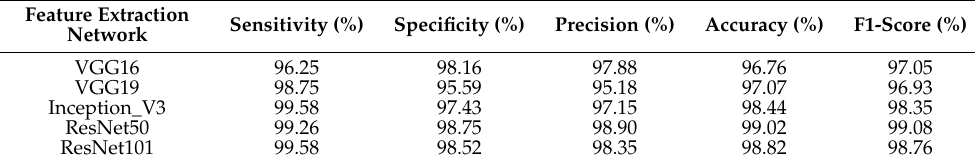
Table 4. WSDAN basic